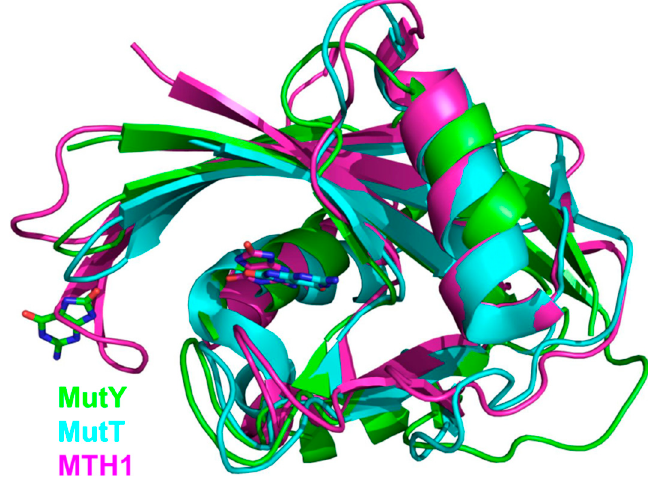
Figure 4. Overlay of NUDIX domains from G. stearothermophilus MutY (green; PDB ID 1RRQ [138]), E. coli MutT (cyan, PDB ID 3A6T [144]), and human MTH1 (magenta, PDB ID 3ZR0 [145]). OxoG bases at their respective binding sites are shown as stick models with carbon atoms colored the same as the respective protein.